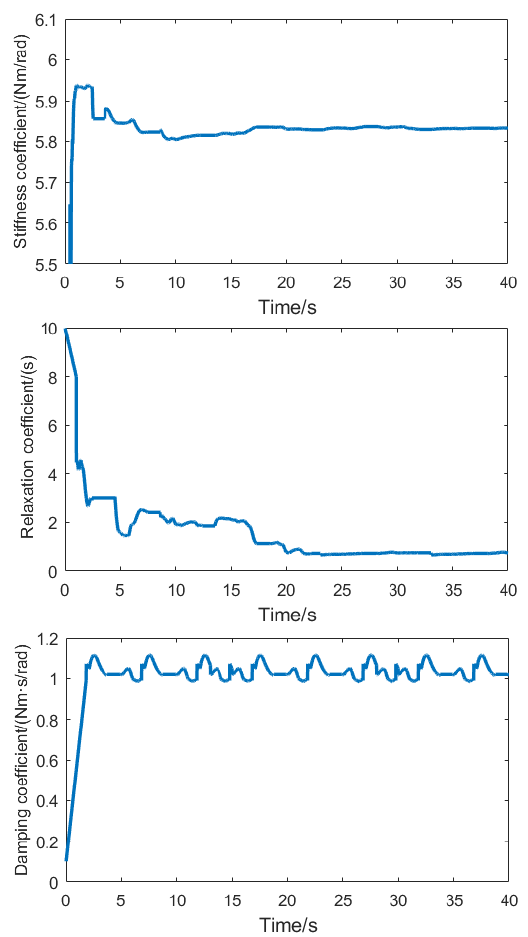
Figure 15. The real-time output rubber model-estimated parameter.